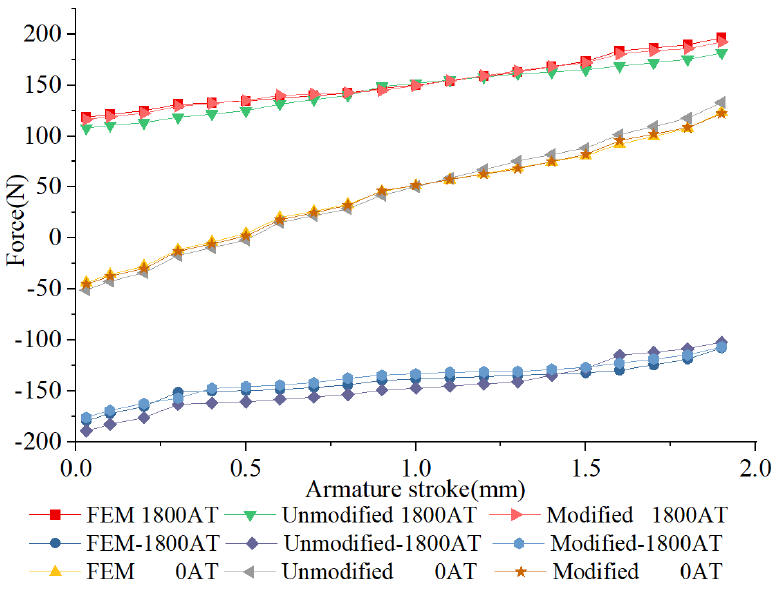
Figure 10. FEM and unmodified and modified DPM force data on the armature.